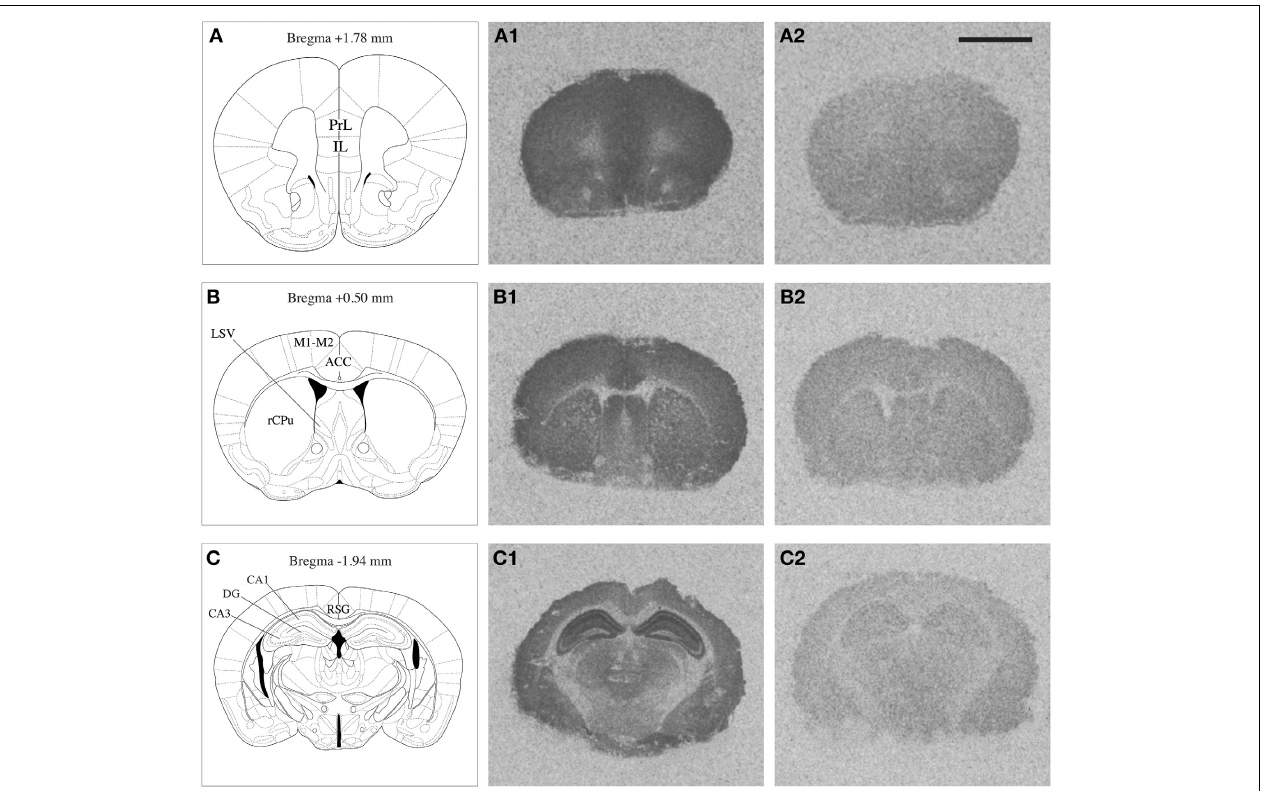
FIGURE 1 | Mouse brain atlas adapted from Paxinos (2004), indicating the brain regions quantified (A,B,C); PrL: prelimbic cortex, IL: infralimbic cortex, rCPu: rostral caudate putamen, M1-M2: motor cortex, ACC: anterior cingulate cortex, LSV: ventrolateral septum, RSG: retrosplenial